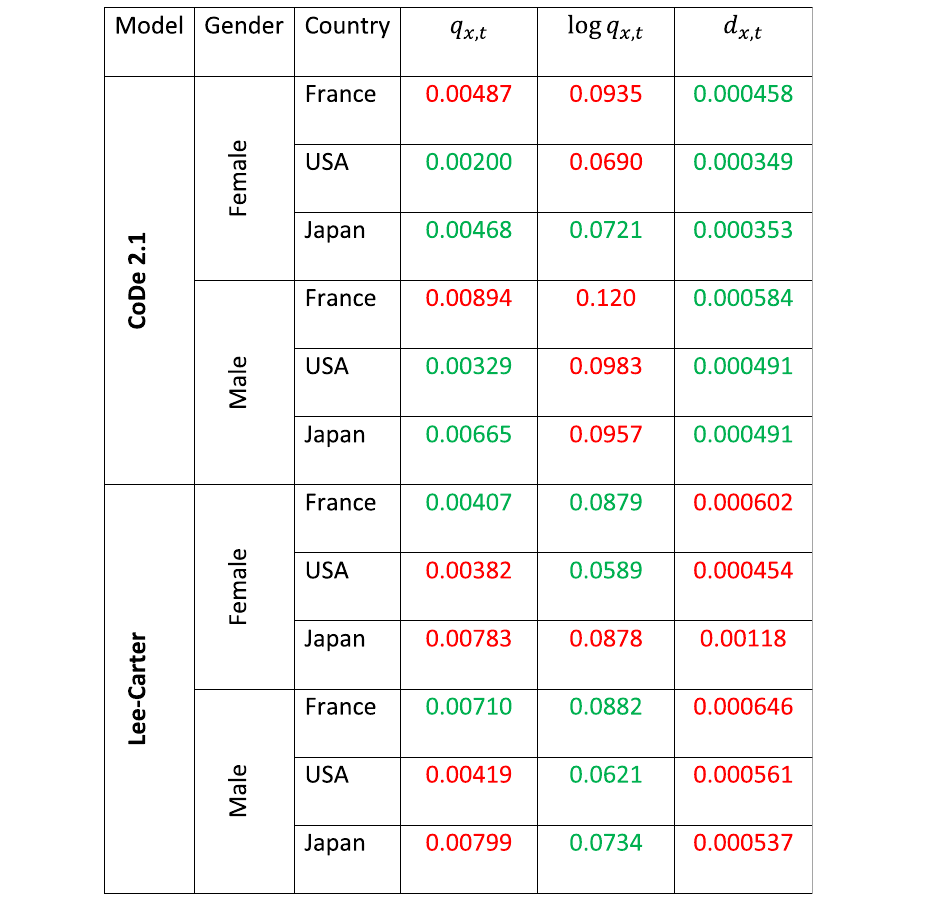
Table 2. Root mean square error (RMSE) of the CoDe 2.1 model and the LC model. Reference period 1960 – 2014 and ages 0 – 100. We use green color for the model with better fit and red color for the model with poorer